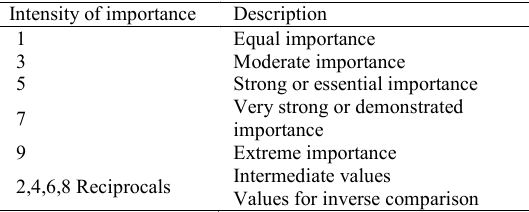
Table 1: Scales for pairwise comparisons (Saaty and Vargas, 1991) Intensity of